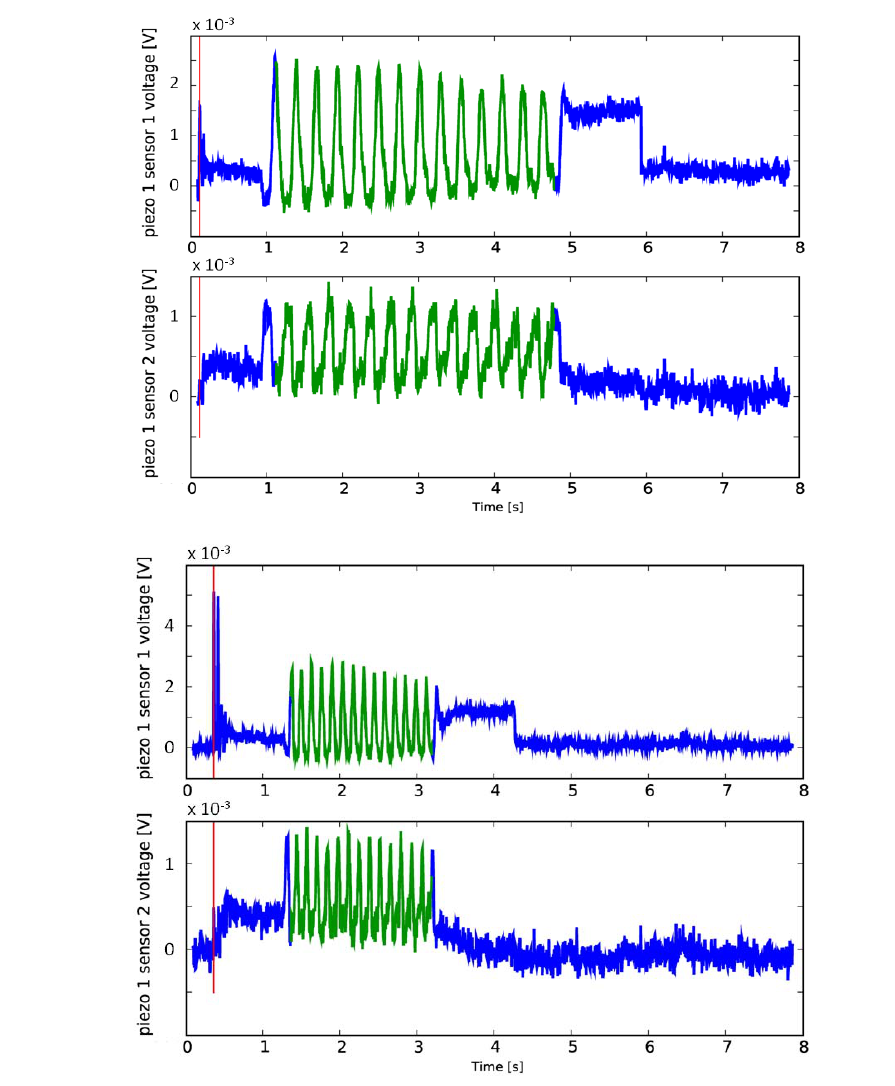
Figure 3. Automatic contact detection applying Equations (2) and (3) and selection of the stimulus sliding phase (phase C, indicated in green in the plots) by means of Equations (4) and (5) using piezoresistor 1 of MEMS sensors 1 and 2 of the array. The plots refer to data series 12 (a) and 16 (b), where a grating of 4.1 mm spatial periodicity was applied with translational speeds of 15 mm/s and 30 mm/s, respectively, according to Tables 2 and 3. The red line marks the detected spike, blue data are cropped for common frequency